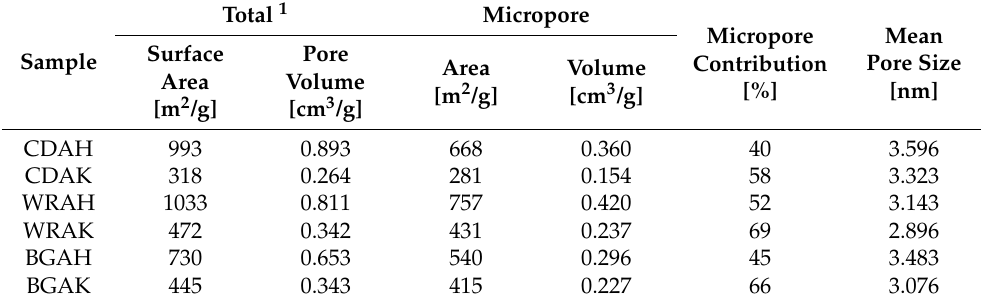
Table 3. Textural parameters of the activated carbons prepared from waste food products.